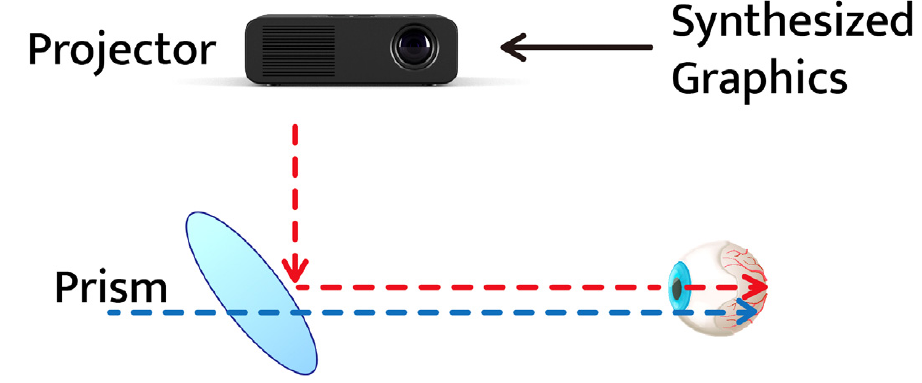
Figure 2. Optical see-through display type.